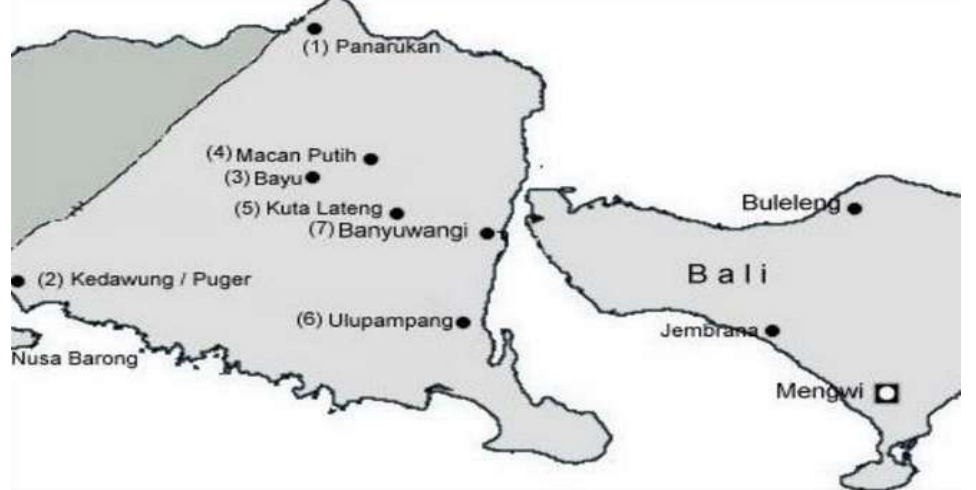
Figure 2. Blambangan Kingdom Location Map Source: Sri Margana